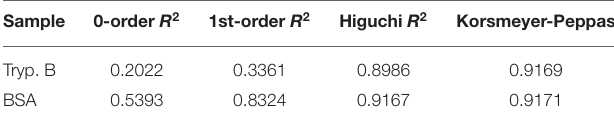
TABLE 2 | Coefficient of determination ( R 2 ) of our data to the three kinetic release models (zero-order release model, first-order release model, and Higuchi release model) and for the drug release mechanism (Korsmeyer-Peppas